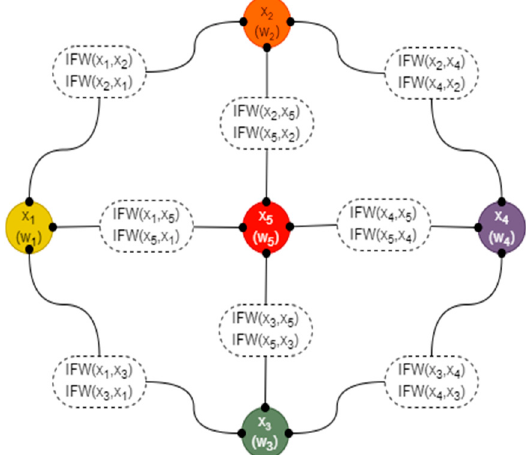
Figure 5. An illustrative of the Feature Connectivity Graph (FCG) .